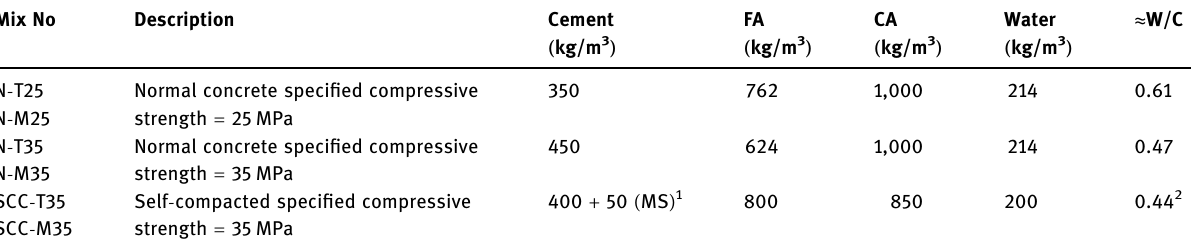
Table 7: SCC mix proportion